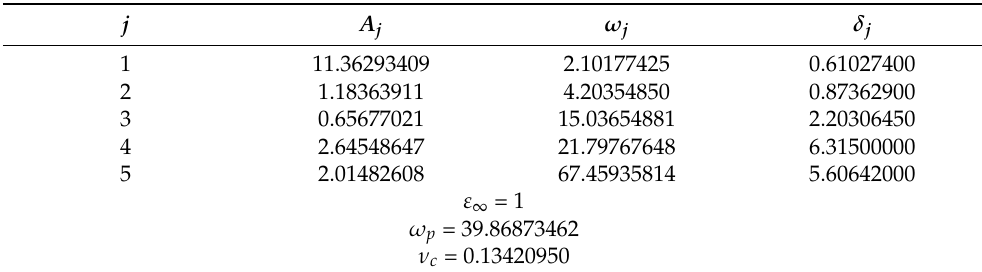
Table 4. Parameters for the Drude–Lorentz’s permittivity model of gold calculated using experimental results in [55,56].